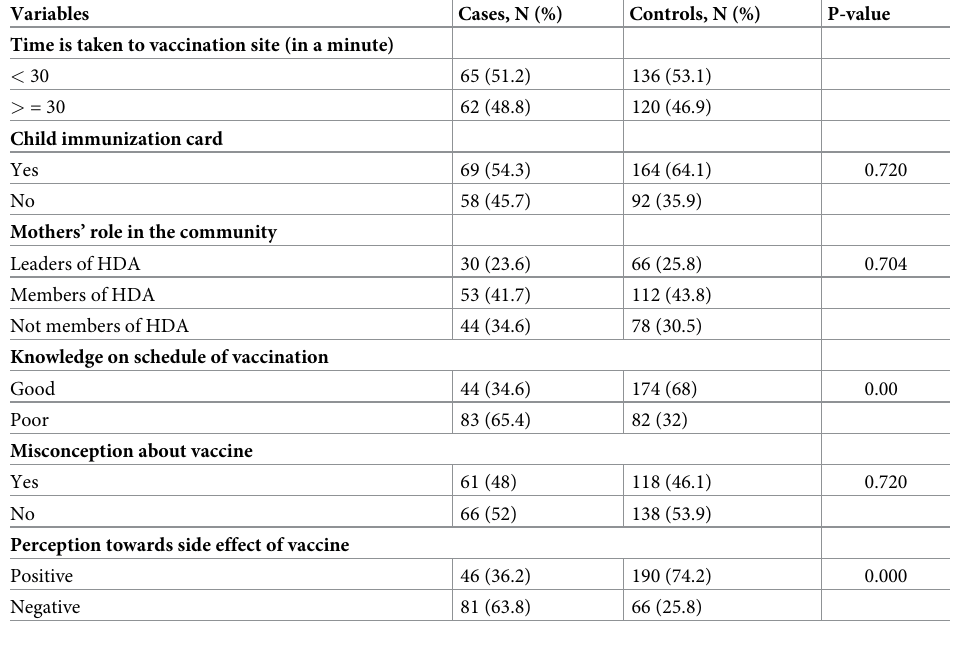
Table 4. Caregiver knowledge, attitude, and perception of immunization in Dabat district, Northwest, Ethiopia, 2021.